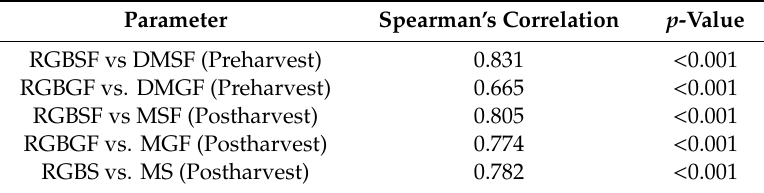
Table 3. The comparison of the manual and RGB sensor-based ground cover